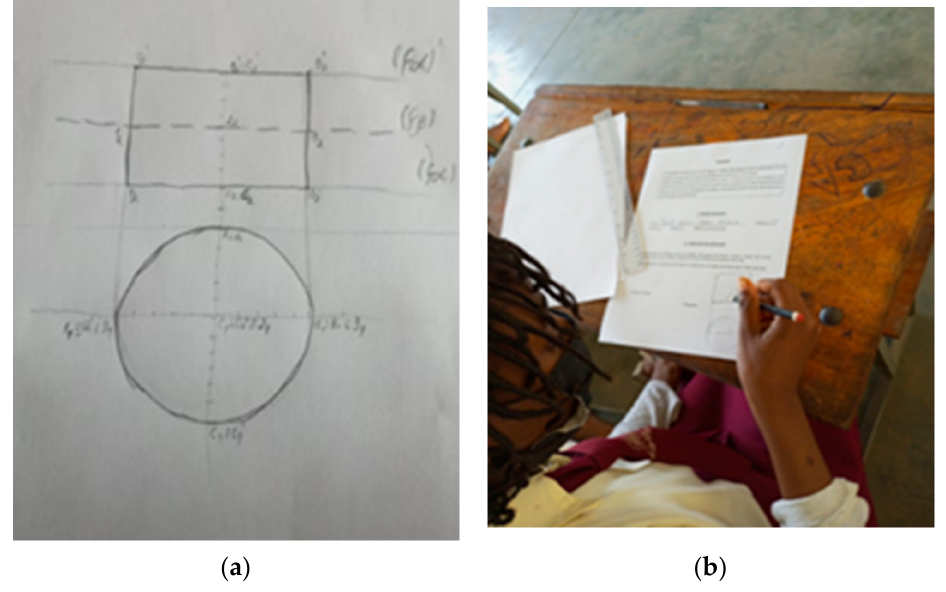
Figure 4. ( a ) Pre-test exercise; ( b ) student solving the pre-test.